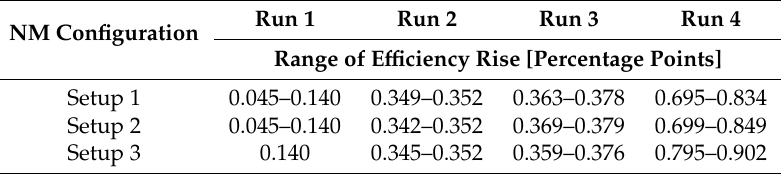
Figure 5. The optimised PP efficiency (a) and computing time (b) for each run and NM setup. Table 7. The efficiency rise in each run and for each NM setup.